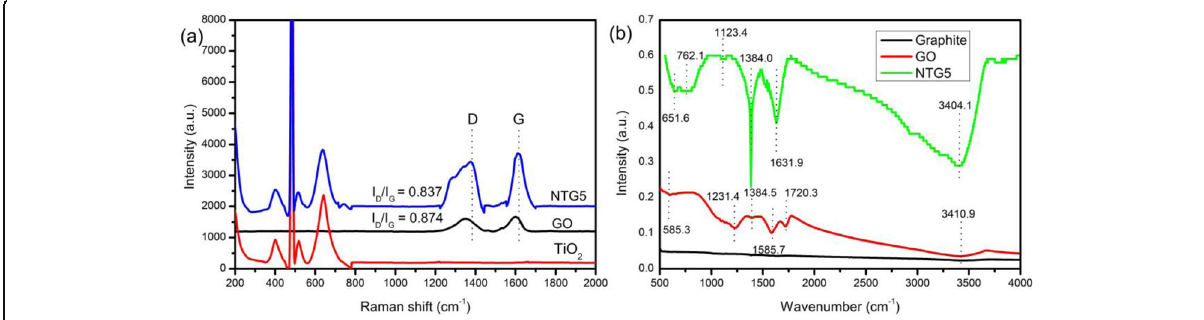
Fig. 7 (a) Raman spectra of TiO 2 , GO and NTG5 (b) FT-IR spectra for Graphite, GO and